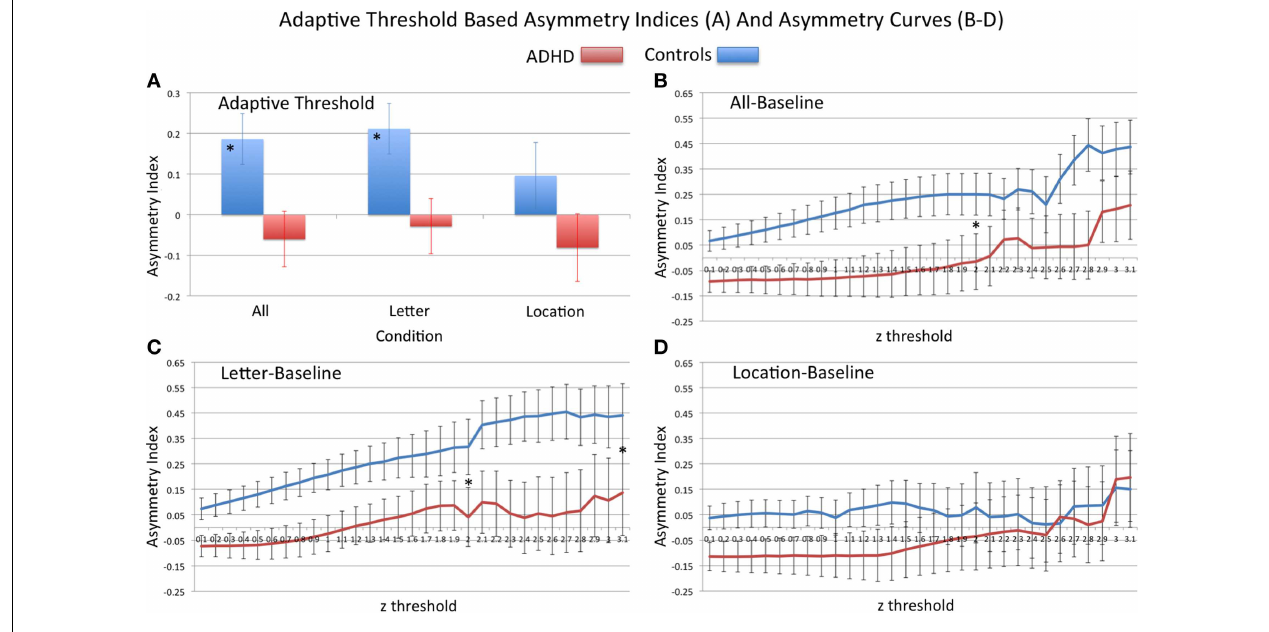
computed from z -thresholds ranging from 0.1 to 2.0 (all–baseline and letter–baseline), and to 3.1 (letter–baseline). At the threshold z = 3.1, n sizes reduced to the following: all–baseline (18 controls, 17 ADHD), letter–baseline (17 control, 16 ADHD), and location–baseline (15 controls, 16 ADHD); Note: positive asymmetry values = leftward